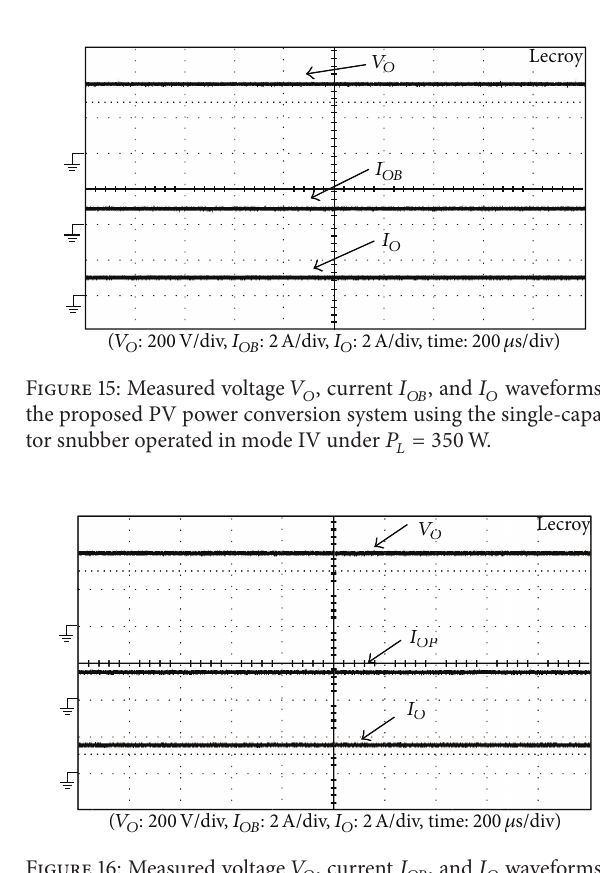
Figure 16: Measured voltage 𝑉 𝑂 , current 𝐼 𝑂𝑃 , and 𝐼 𝑂 waveforms of the proposed PV power conversion system using the single-capaci- tor snubber operated in mode VI under 𝑃 𝐿 = 600